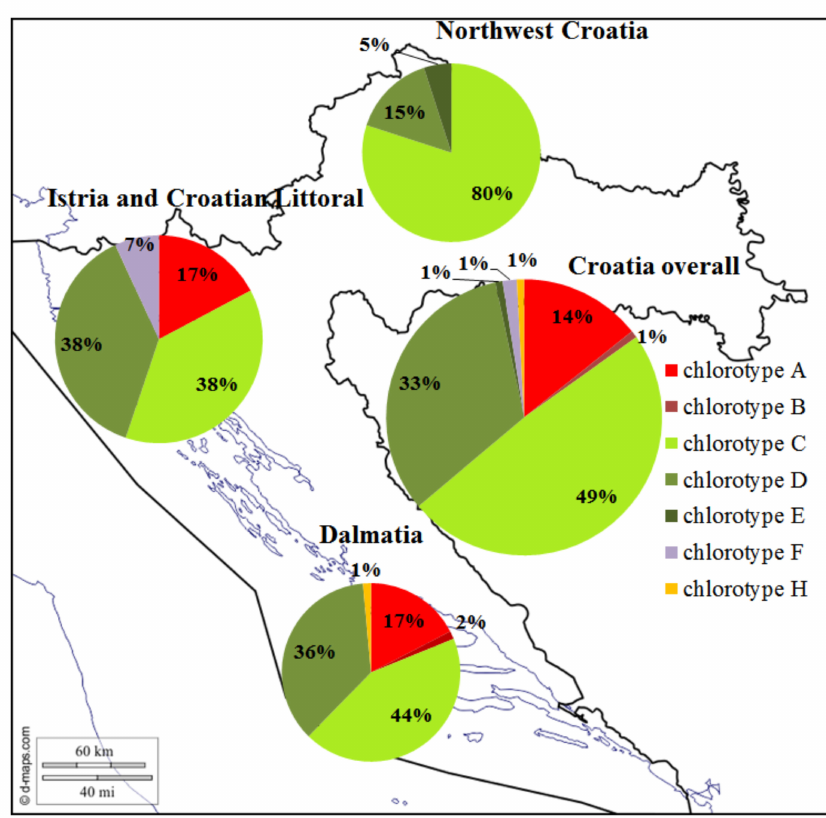
Figure 2. Graphical representation of chlorotype distribution across regions of